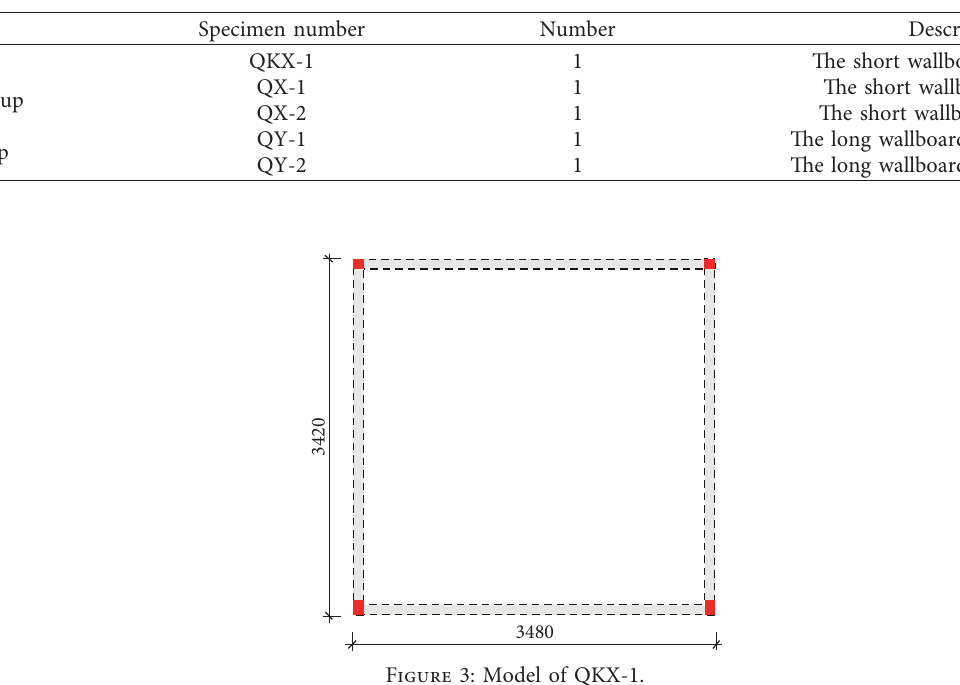
Figure 2: Boundary condition. Table 1: Specimen grouping.